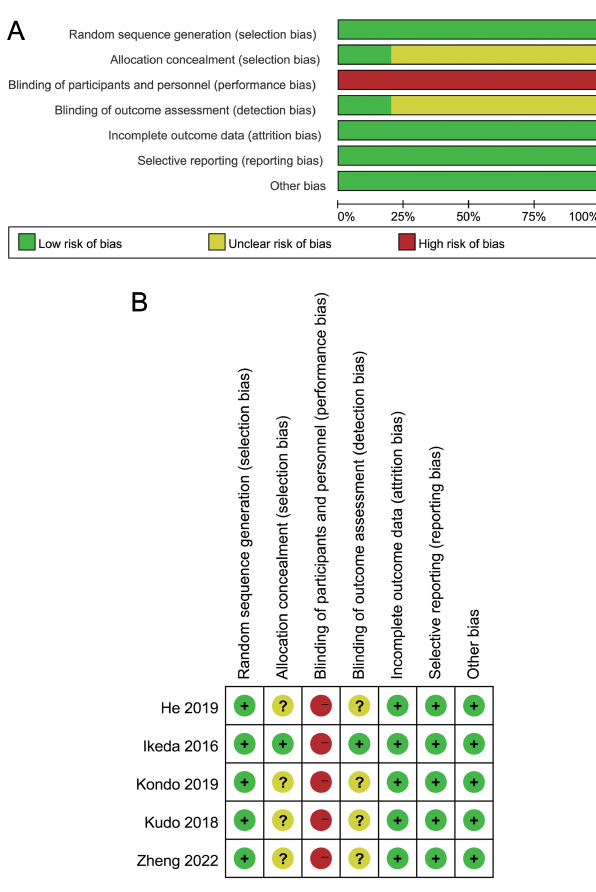
Figure 2. (A) The research quality of the RCTs, and (B) risk of bias graph risk of bias summary. RCTs, randomized controlled